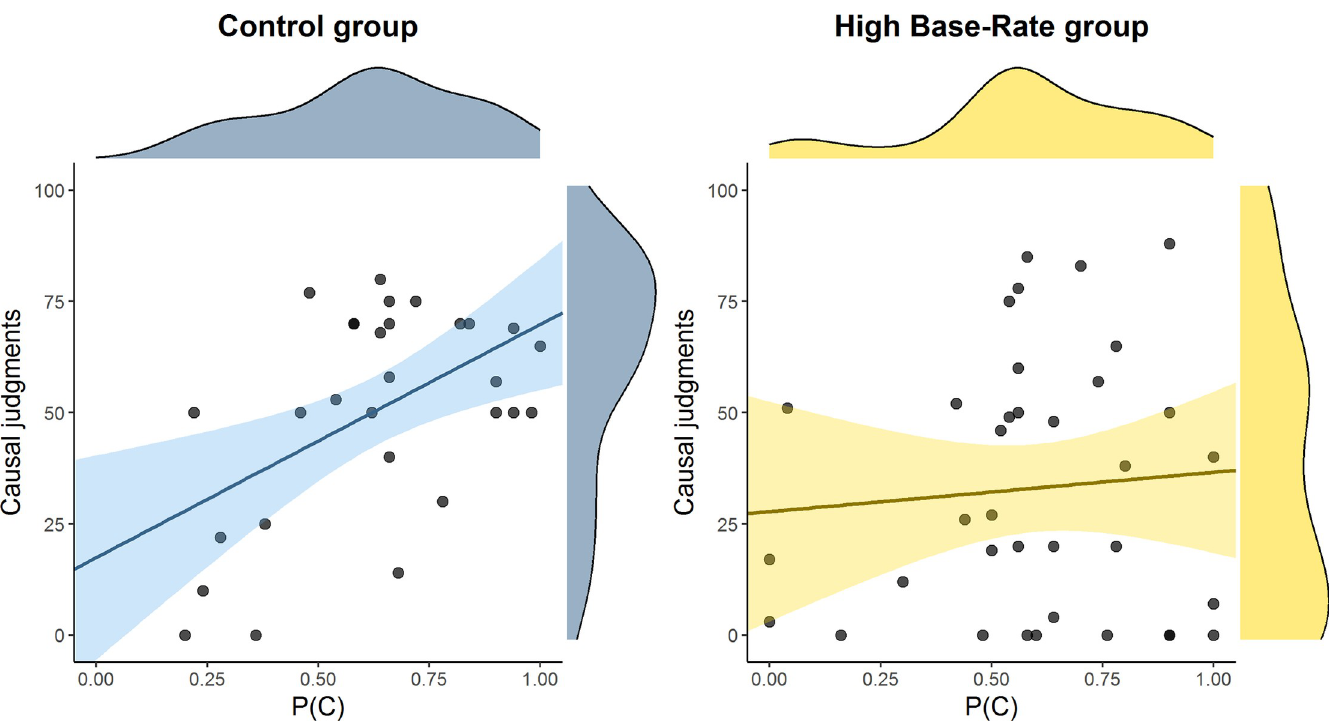
Fig 3. Scatter plot depicting the relation between P(C) and causal judgments in the two groups of Experiment 1, including marginal densities. Shaded areas represent 95% CIs for the regression slopes.